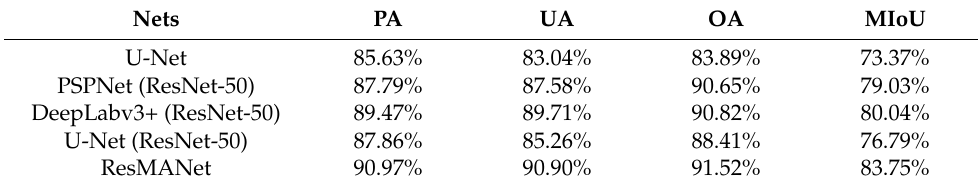
Figure 16. Prediction examples in the validation set of the public dataset. ( a1 , a2 ) True color images. ( b1 , b2 ) Ground truth images. ( c1 – c5 , e1 – e5 ) Predictions of U-Net, PSPNet (ResNet-50), DeepLabv3+ (ResNet-50), U-Net (ResNet-50) and ResMANet. ( d1 – d5 , f1 – f5 ) Corresponding difference maps. Table 6. Accuracy assessment of the public dataset results between methods.